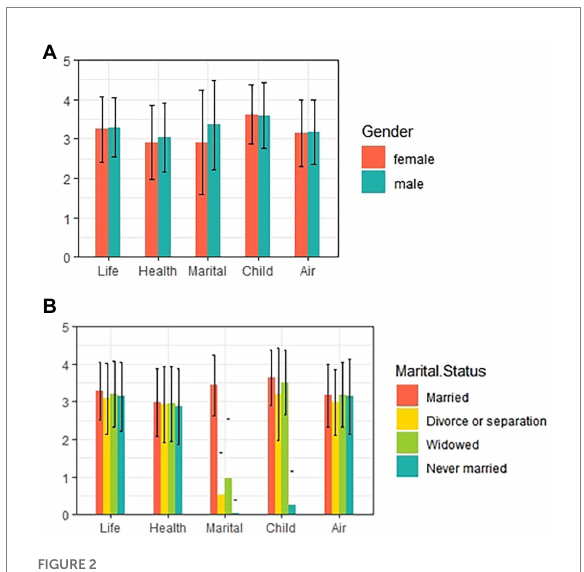
FIGURE 2 The distribution of five dimensions of subjective well-being: (A) Distribution in sex; (B) Distribution in marital status.